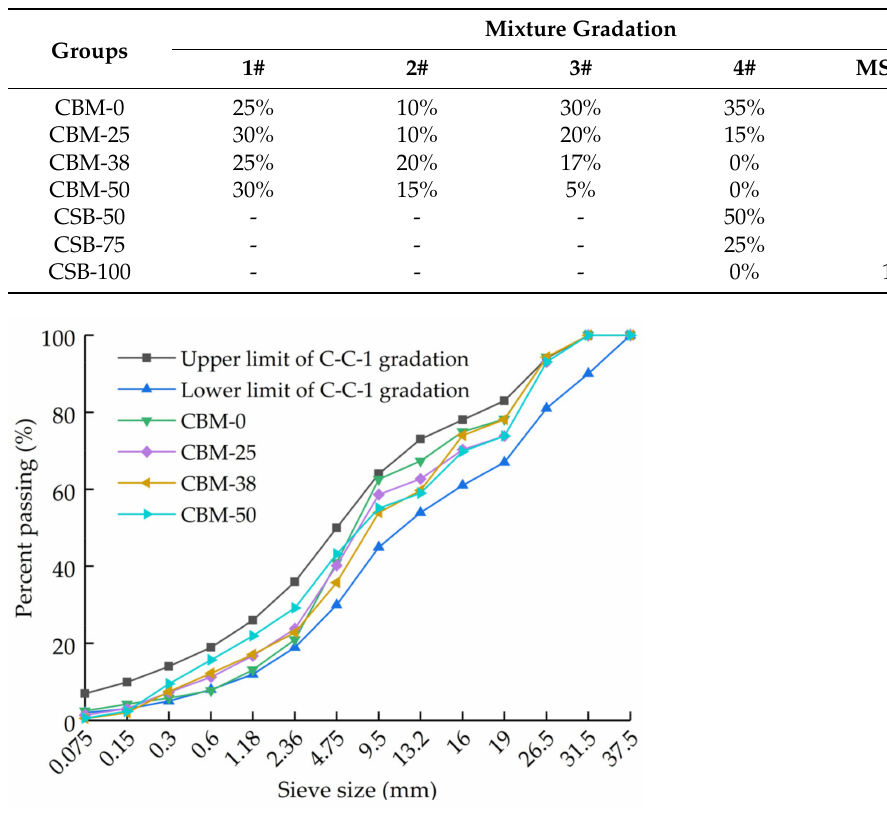
Table 6. Mix ratio design of mixtures.